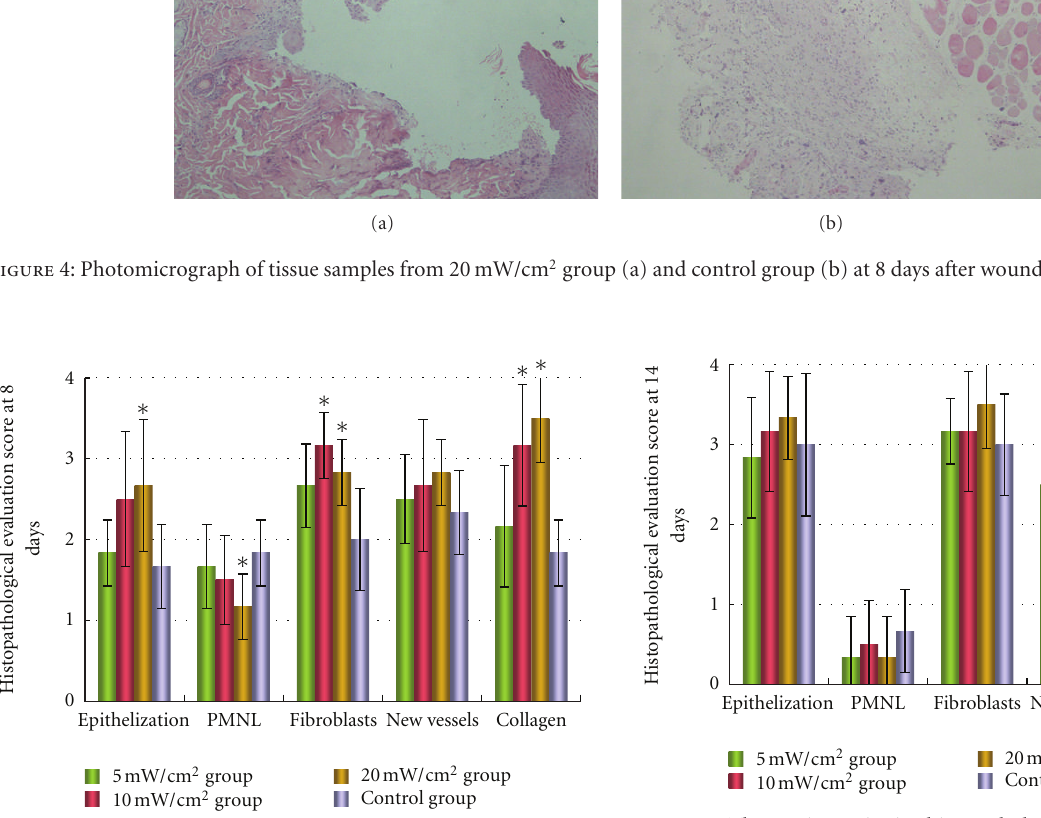
Figure 5: The semiquantitative histopathological evaluation score at 8 days after wounding. Asterisk means that this group has statistical di ff erence with control group ( P < 0 . 05).